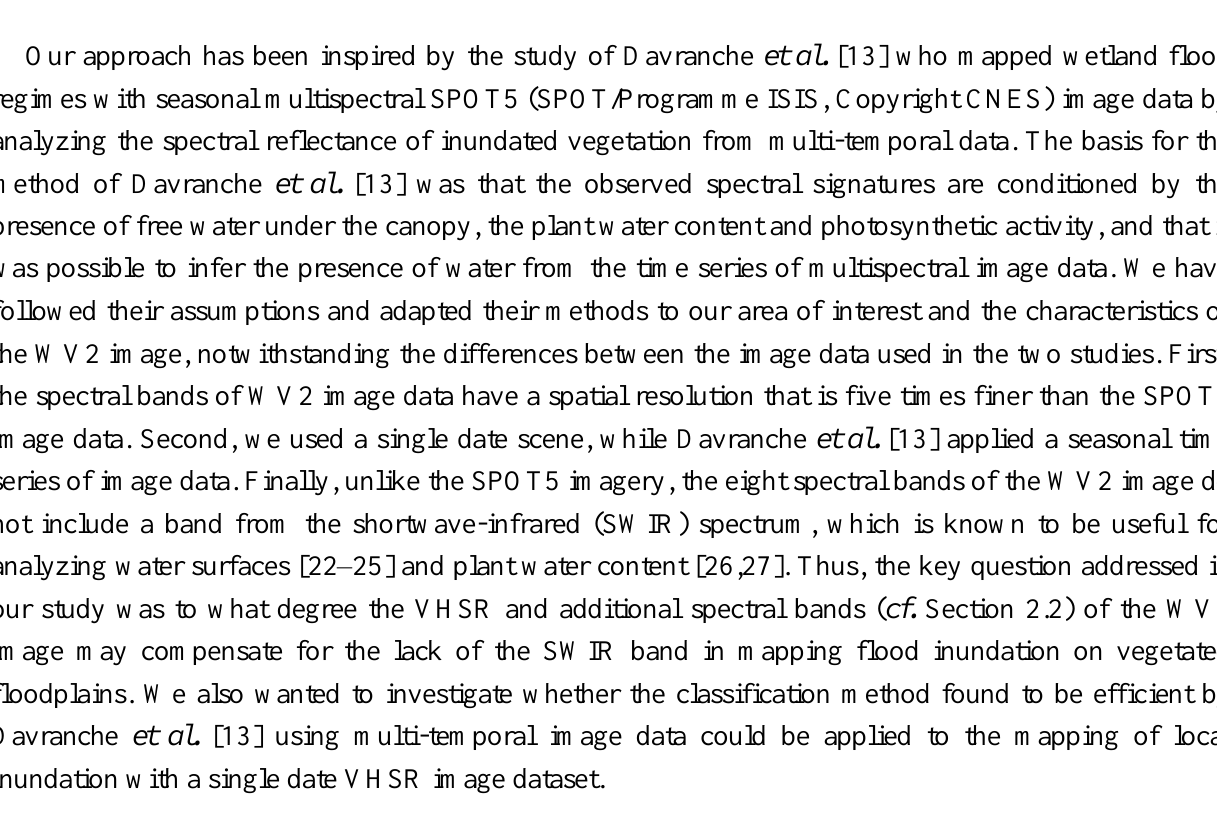
Figure 1. Example of localized flooding in the Nørreå river valley at Vejrumbro, (Denmark), picturing interspersed vegetation and water